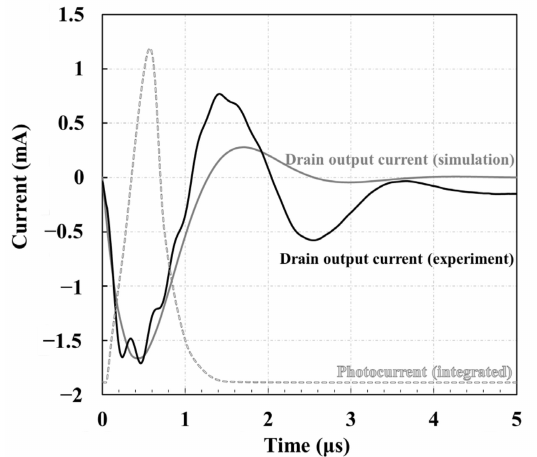
Figure 7. Detection for Ps with comparison of current results based on photocurrent measurement process by noise canceling